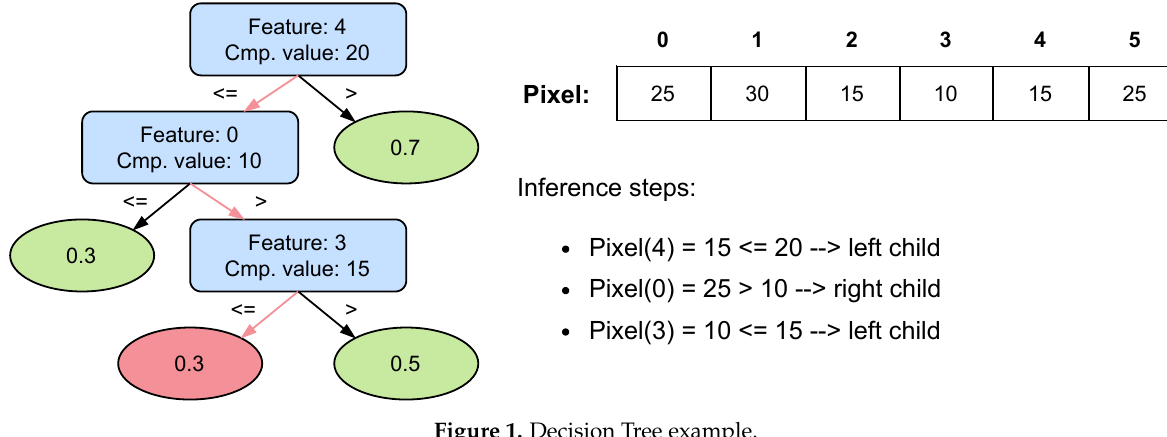
Figure 1. Decision Tree